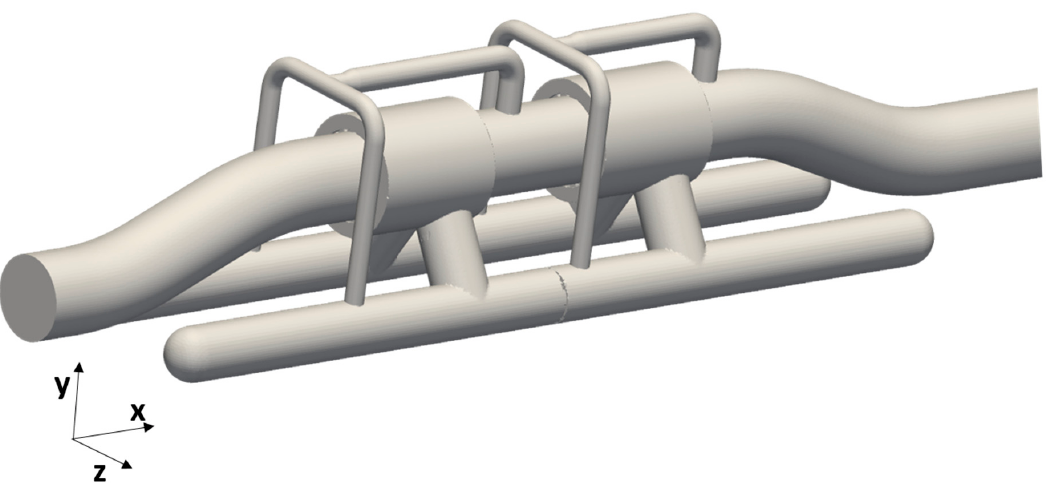
Figure 9. Geometry of the second separator design.